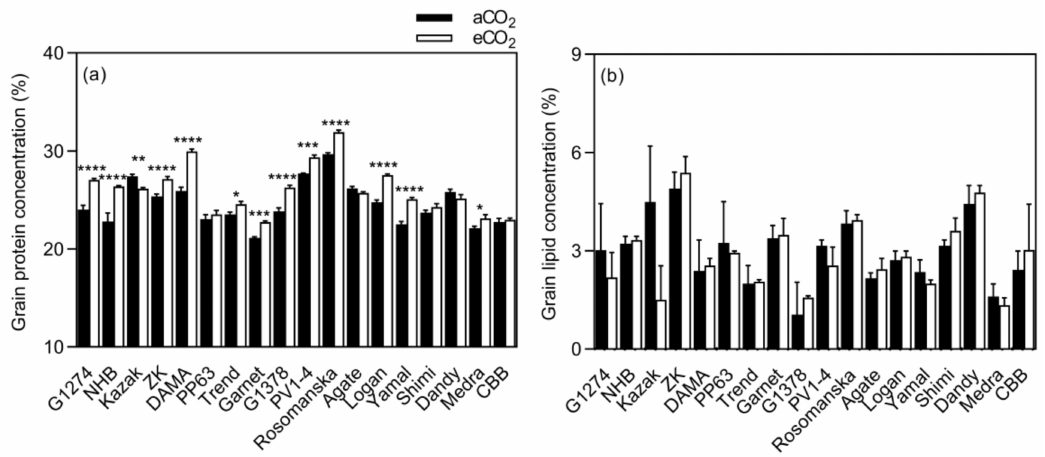
Figure 6. Influence of eCO 2 on bean seed protein and lipid concentrations. Each bar represents the mean ± SE ( n = 10 plants). * p < 0.05; ** p < 0.01; *** p < 0.001; **** p < 0.0001 significance level.